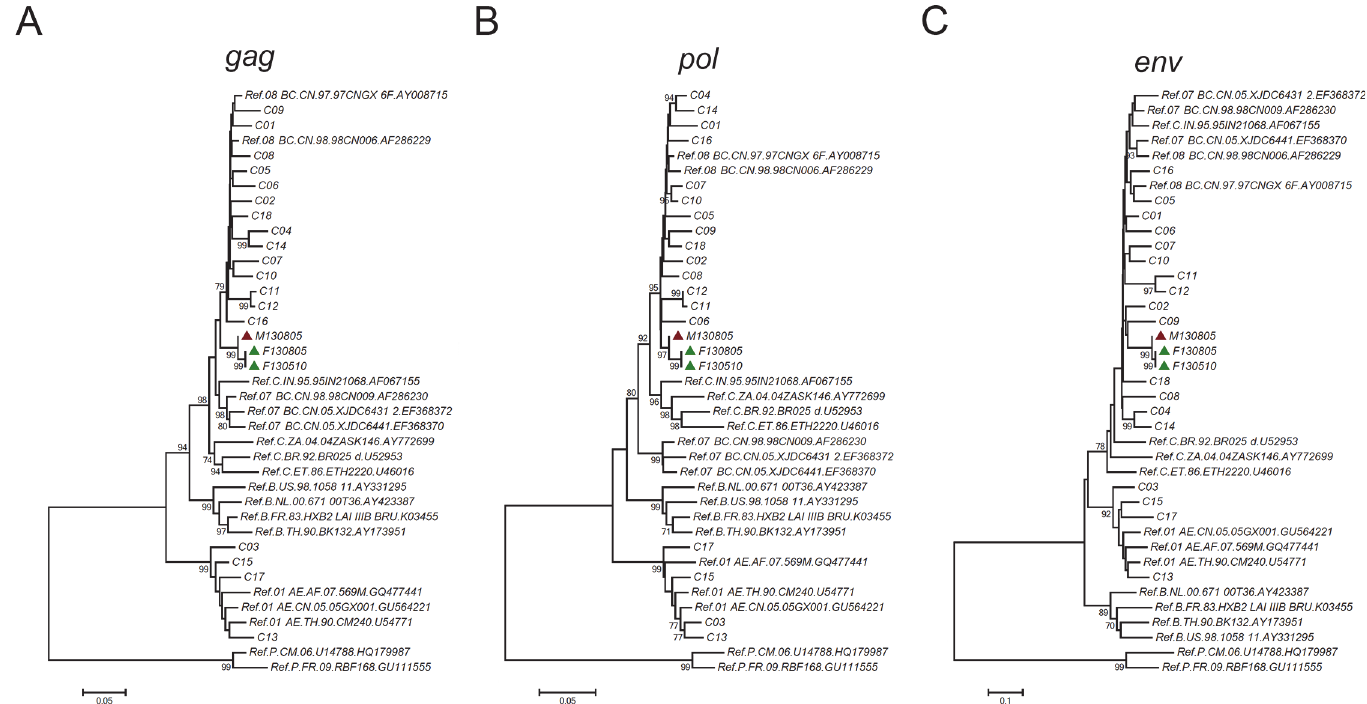
Fig 1. Neighbor-joining phylogenetic tree of consensus sequences from the man, the woman and local controls. A, Neighbor-joining phylogenetic tree for consensus gag sequences and reference sequences. The scale bar indicates 5% nucleotide sequence divergence. B, Neighbor-joining phylogenetic tree for consensus pol sequences and relative reference sequences. The scale bar indicates 5% nucleotide sequence divergence. C, Neighbor-joining phylogenetic tree for consensus env sequences and relative reference sequences. The scale bar indicates 10% nucleotide sequence divergence. Values on the branches represent the percentage of 1000 bootstrap replicates and bootstrap values over 70% are shown in the tree. Red triangle: the sequence from the male source; Green triangle: the sequences from the female